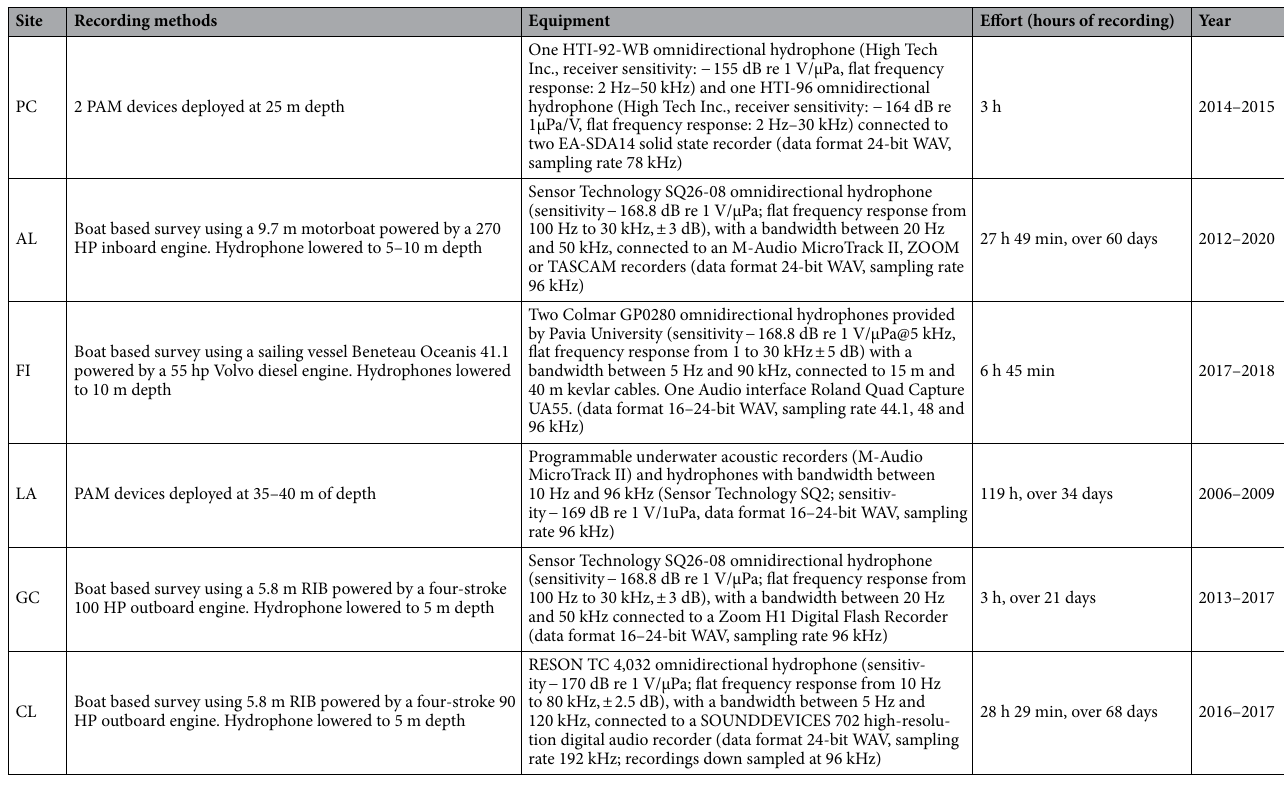
Table 6. Research boats and equipment used, effort and sampling periods for the six sites. Port Cros (PC), Alghero (AL), Ostia-Fiumicino (FI), Lampedusa (LA), Gulf of Corinth (GC), Cres and Losinj